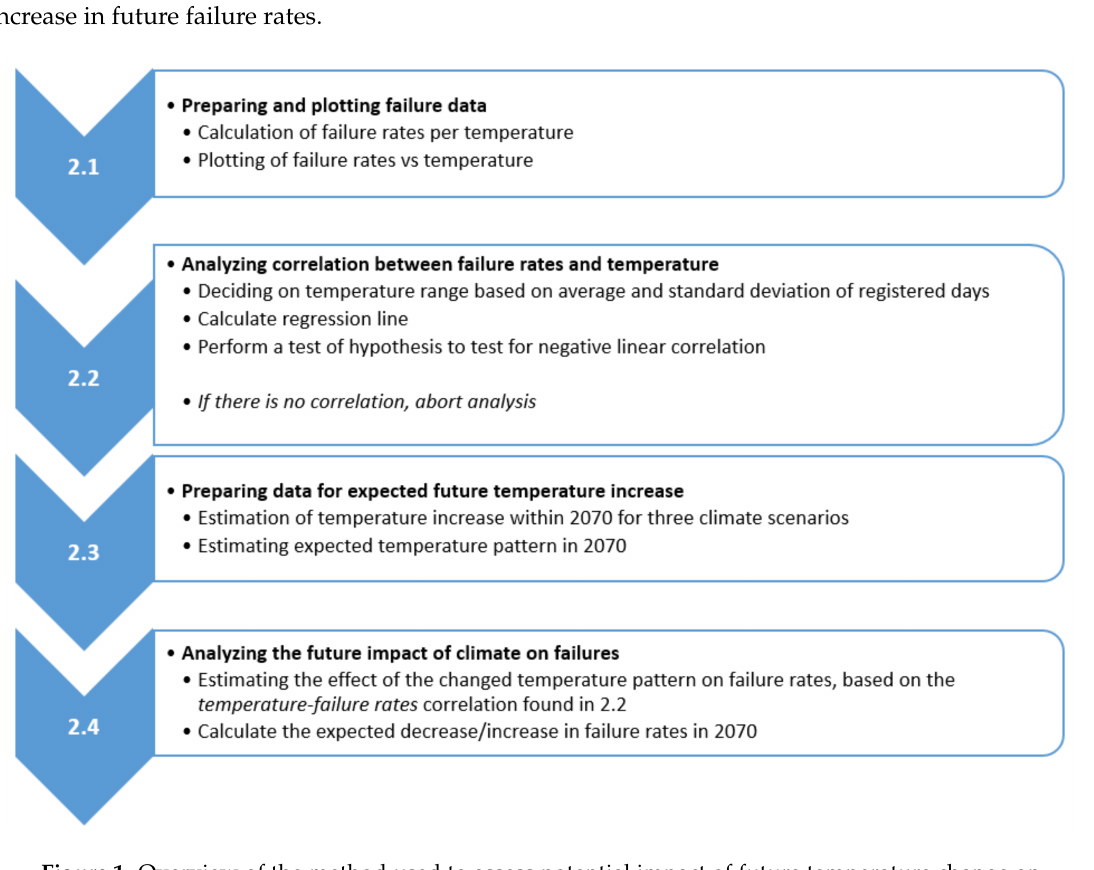
Figure 1. Overview of the method used to assess potential impact of future temperature change on failure